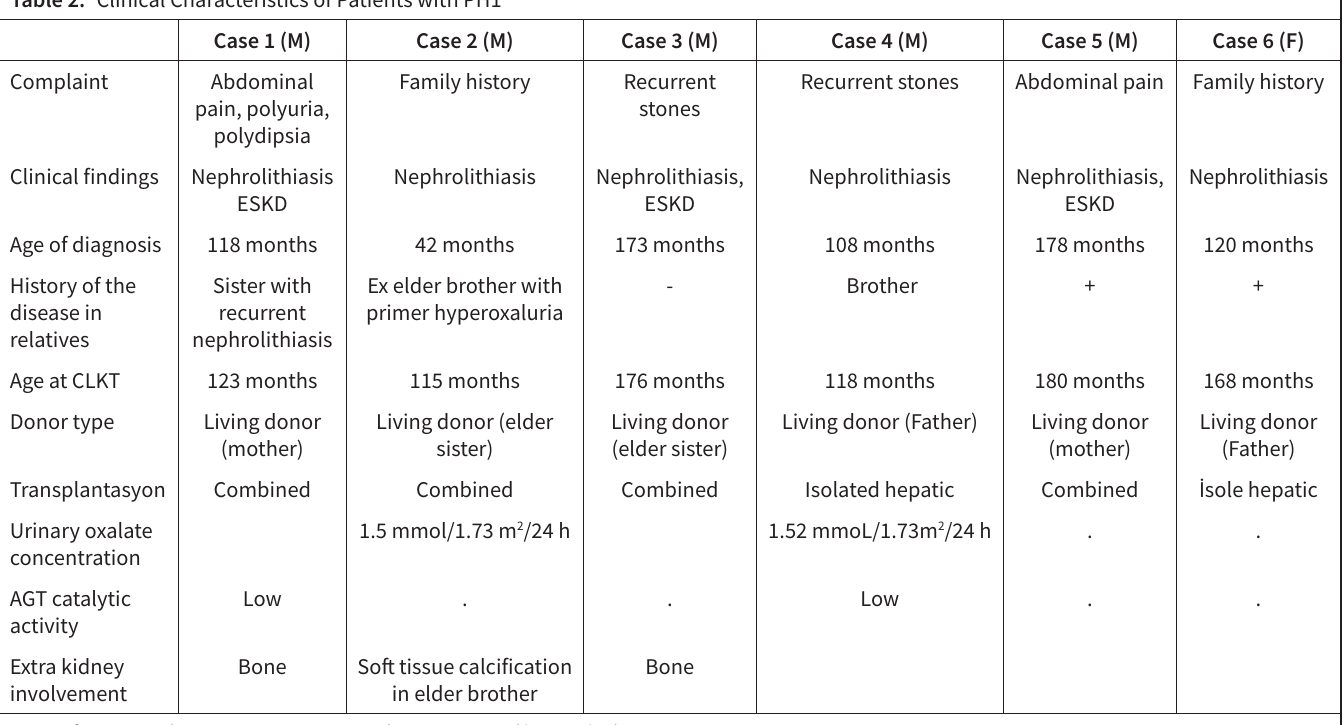
Table 2. Clinical Characteristics of Patients with